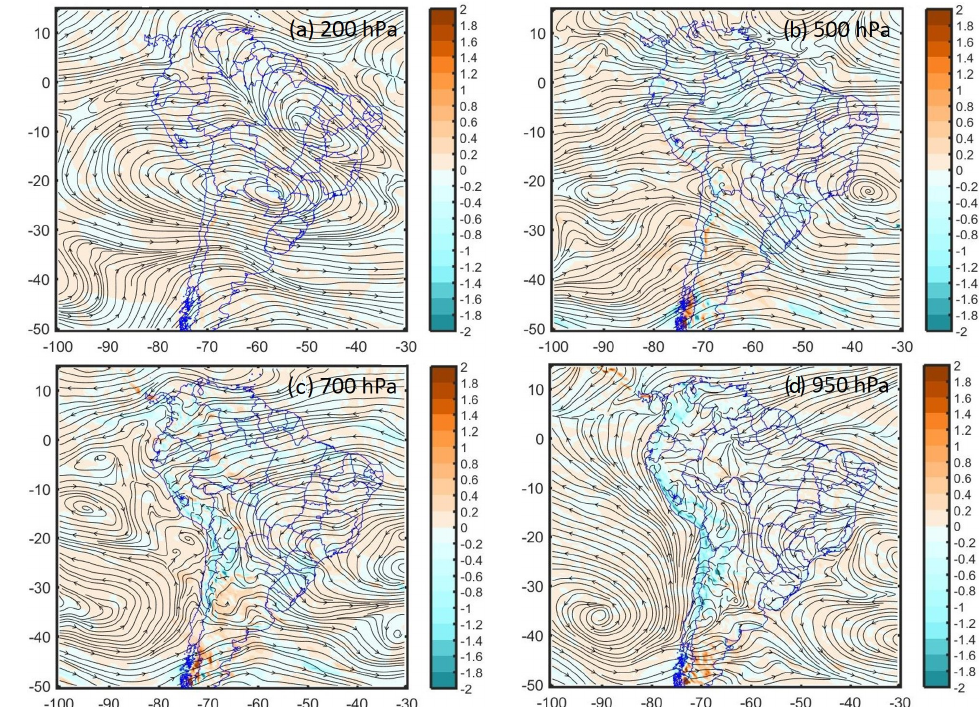
Figure 5. Composites of wind streamlines (m s − 1 ) and mean vertical velocities (Pa s − 1 ) for the event on 17 January 2018 at 18 UTC (13 LT) for high levels: ( a ) 200 hPa, mid levels: ( b ) 500 hPa, ( c ) 700 hpa and low levels: ( d ) 950 hPa. Positive values indicate downdraft vertical winds and negative values indicate updraft vertical winds. All composites data were obtained from GFS- reanalysis data (resolution: 0.5 ◦ ). Longitudes, latitudes and contours of the MRB and Mantaro valley are